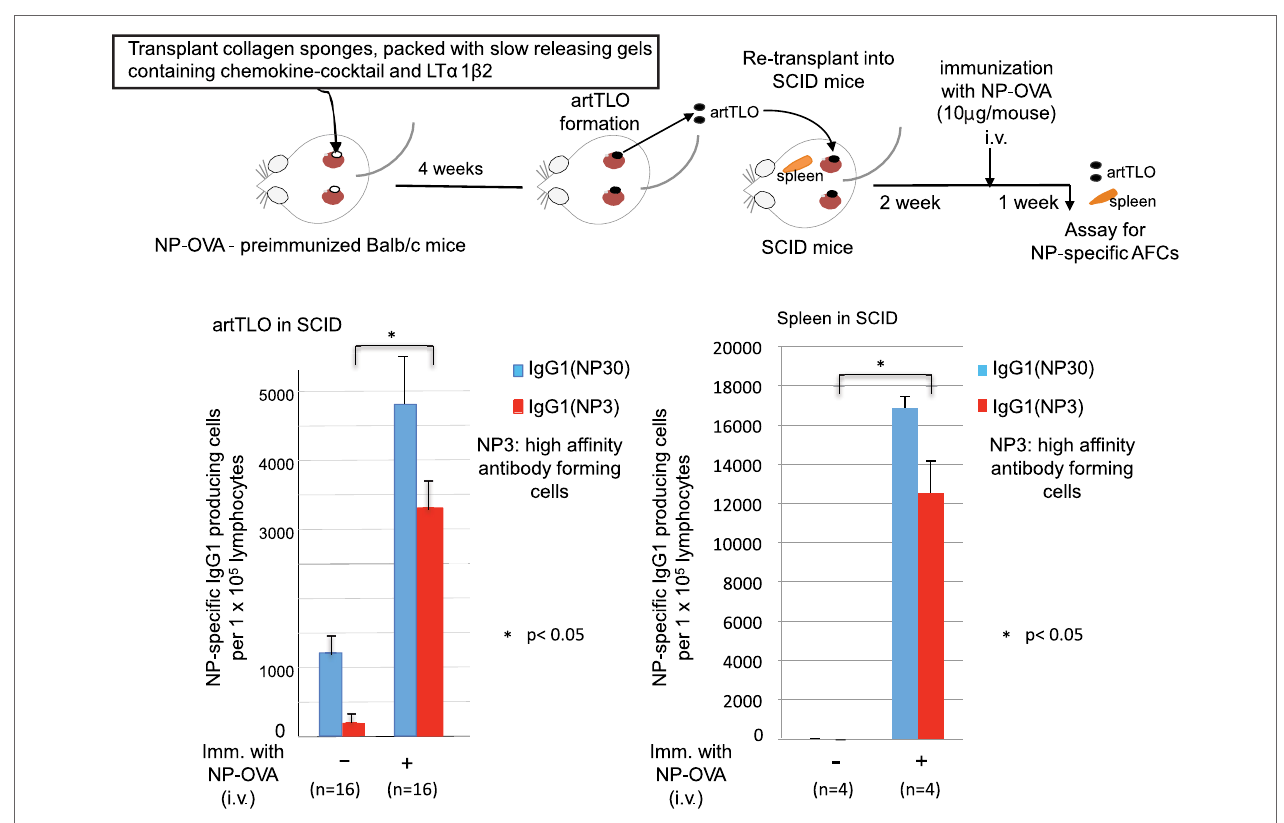
FigUre 3 | enrichment of antigen-specific high-affinity antibody-producing cells in artTlO upon transplantation into immunodeficient sciD mice . ArtTLO were first formed in eight NP-OVA preimmunized Balb/c mice as described in Figure 2 . Four artTLO (two artTLO in each kidney) in one mouse were constructed. Then, artTLO were individually extirpated and collected from Balb/c mice and re-transplanted into renal subcapsular space of eight SCID mice. Four artTLO were re-transplanted into each SCID mouse. Two weeks after re-transplantation, four of artTLO-carrying SCID mice were intravenously immunized with 10 μ g NP-OVA. The other four SCID mice were not immunized. One week after, artTLO and recipient spleen were extirpated individually from SCID mice and single cell suspensions were prepared. Numbers of high affinity as well as total IgG class anti-NP antibody-forming cells (AFCs) in individual artTLO and in spleens of recipient SCID mice were counted by an immunospot analyzer. Numbers of AFCs were calculated from 16 individual artTLO for each